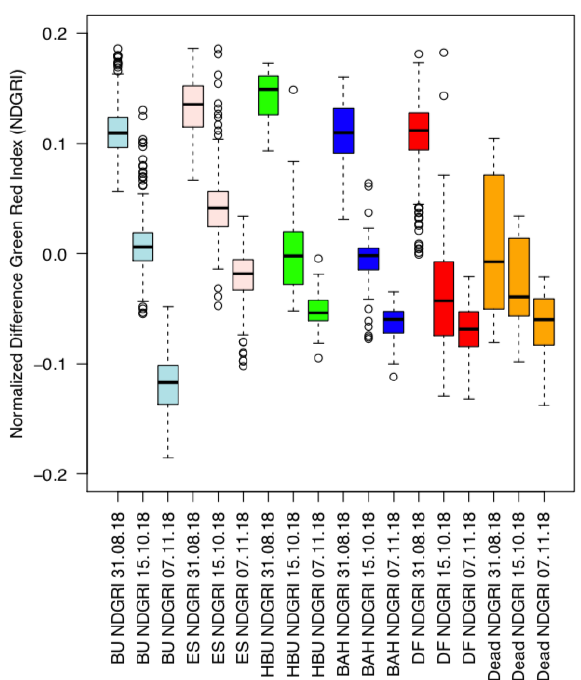
Figure 6: Normalized Difference Green-Red Index values for August, October and November RGB data of the dominating tree species (beech (BU), ash (ES), maple (BAH), hornbeam (HBU) and November-defoliated (DF)/ dead crown class.